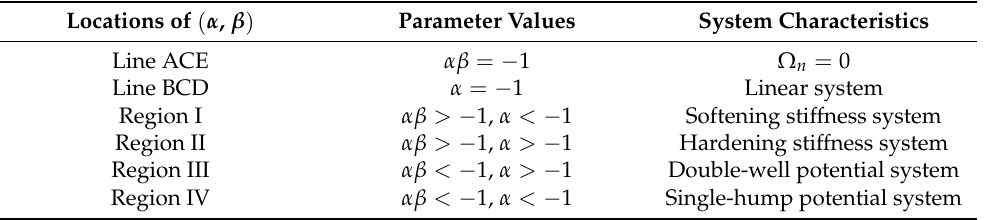
Figure 5. The bifurcation set of the unforced system. Table 1. Different categories of the